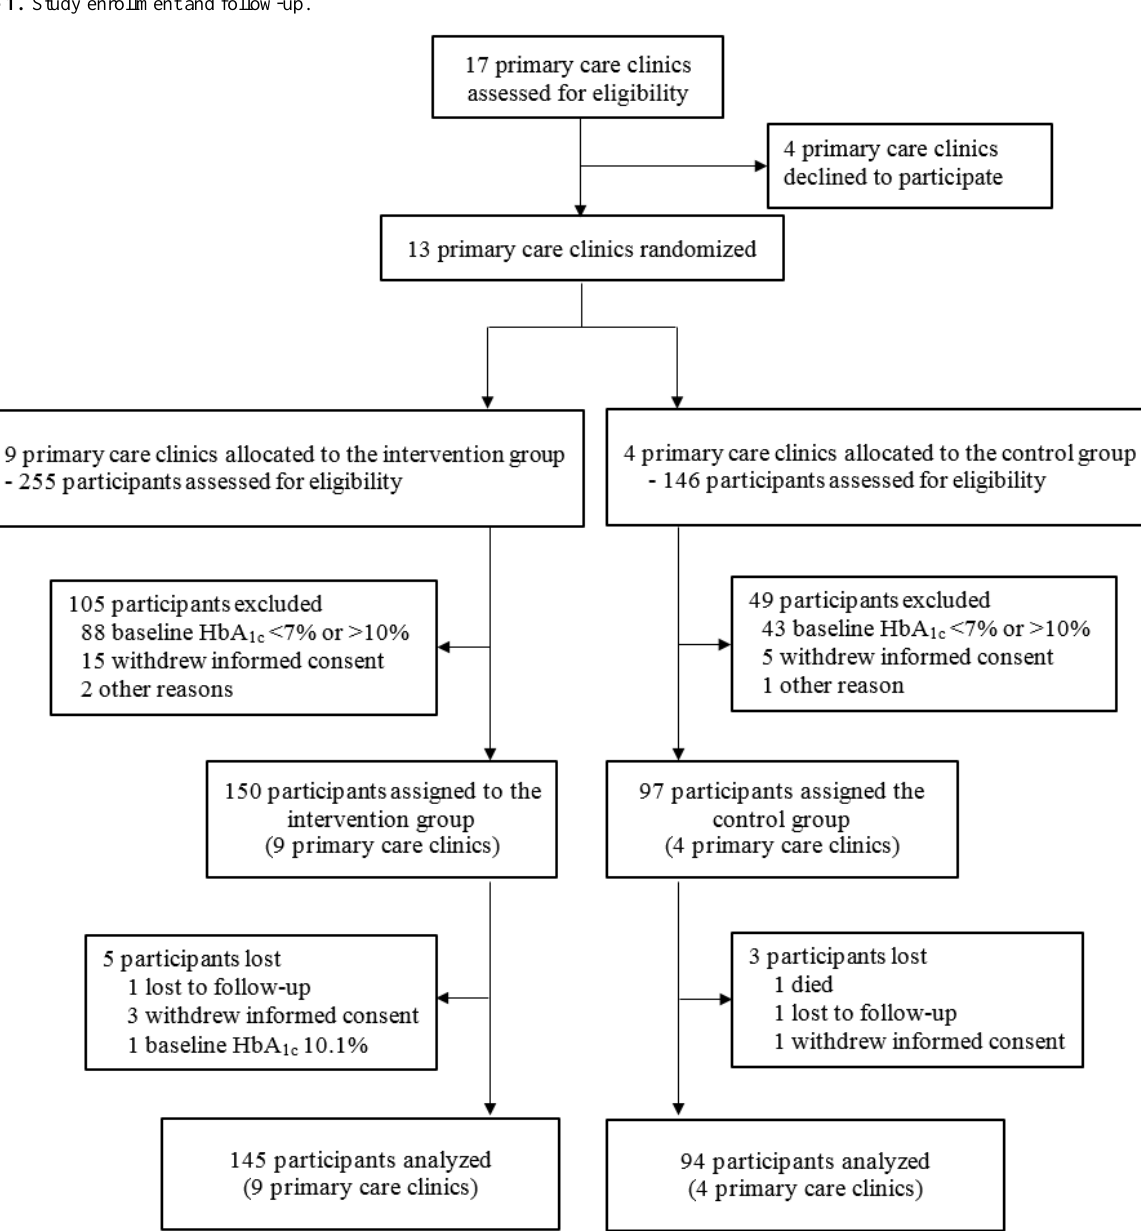
Figure 1. Study enrollment and